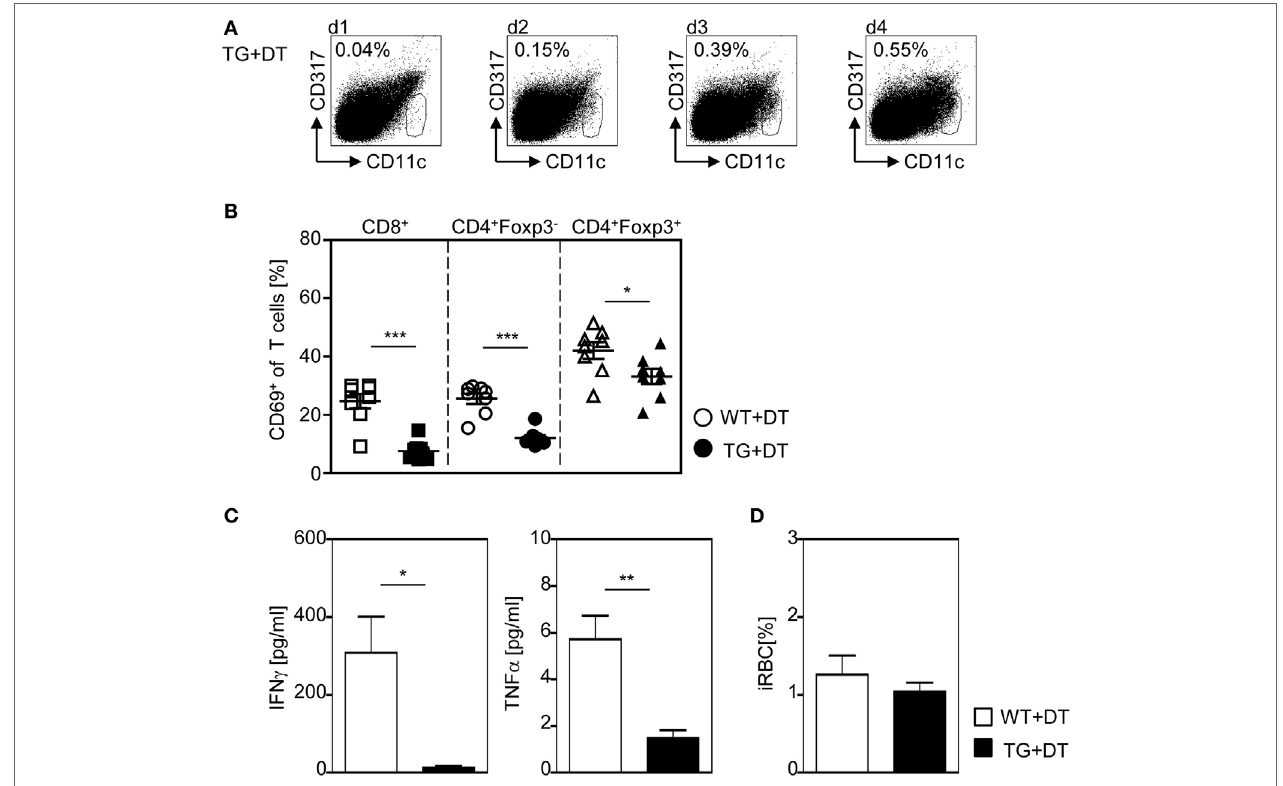
FigUre 7 | A single diphtheria toxin (DT)-injection 1 day before Plasmodium yoelii infection is sufficient to restrict dendritic cells (DC)-mediated T cell activation. RosaiDTR/CD11c-cre (TG) and RosaiDTR wild-type (WT) mice were treated once with DT ( + DT) 1 day before infection with P. yoelii. (a) The percentage of CD11c high DCs in uninfected DT-treated RosaiDTR/CD11c-cre mice was analyzed from days 1 to 4 after DT treatment in the spleen by flow cytometry. Representative dot plots are shown. At day 3 post infection (B) , the frequencies of CD69-expressing CD8 + , CD4 + Foxp3 − T cells, and CD4 + Foxp3 + Tregs were determined by flow cytometry, (c) the amount of IFN- γ and TNF- α was measured in the serum by Luminex technology, and (D) parasitemia was determined by Giemsa-staining. Results from two independent experiments with n = 8 mice were summarized as mean ± SEM. Student’s t -test test was used for statistical analysis. * p < 0.05; ** p <